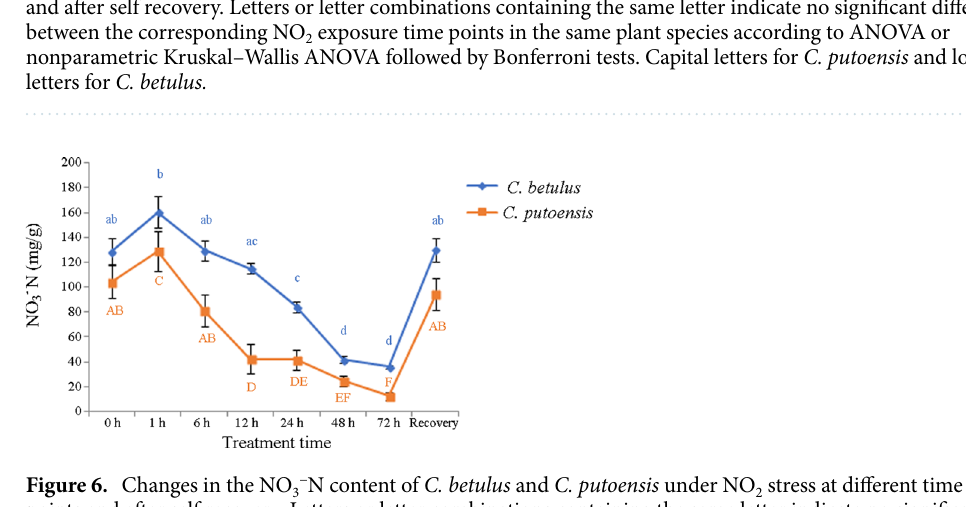
Figure 6. Changes in the NO 3 − N content of C. betulus and C. putoensis under NO 2 stress at different time points and after self recovery. Letters or letter combinations containing the same letter indicate no significant difference between the corresponding NO 2 exposure time points in the same plant species according to ANOVA or nonparametric Kruskal–Wallis ANOVA followed by Bonferroni tests. Capital letters for C. putoensis and lower letters for C.